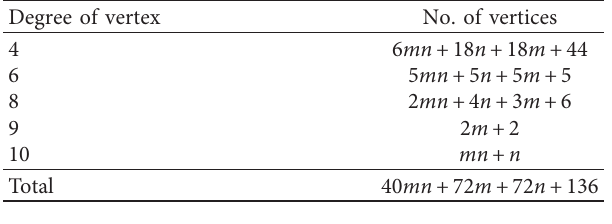
Table 1: The vertex partition of graph G based on degree of vertices. Degree of